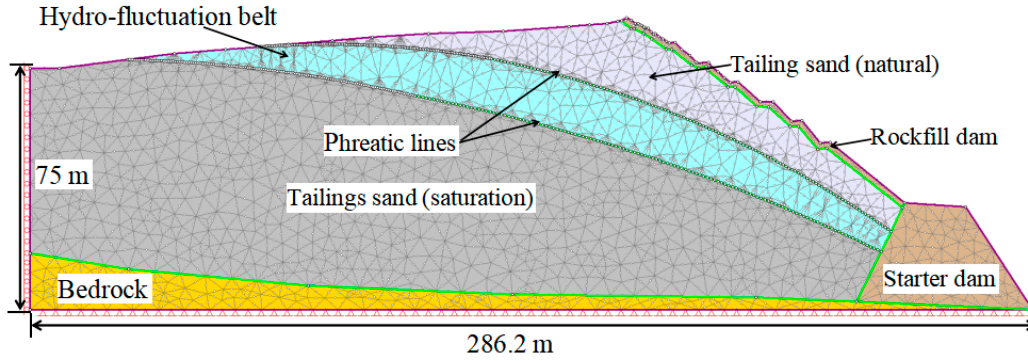
Table 3. Tailings dam calculated results after DW